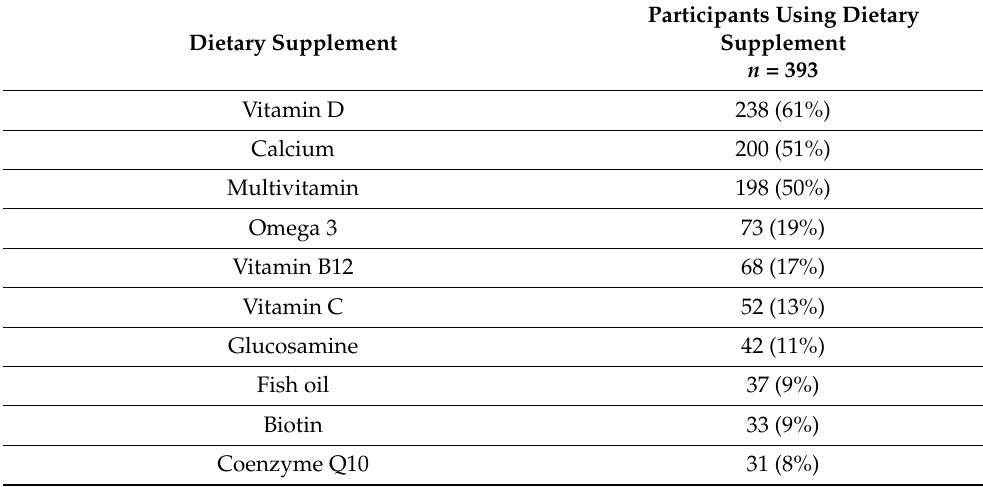
Table 3. Top 10 dietary supplements reported among the women reporting use of dietary supplements ( n = 393).